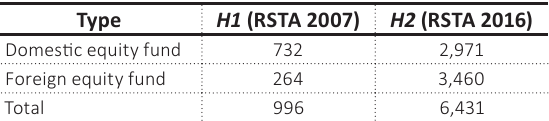
Table 3. Size of sample funds